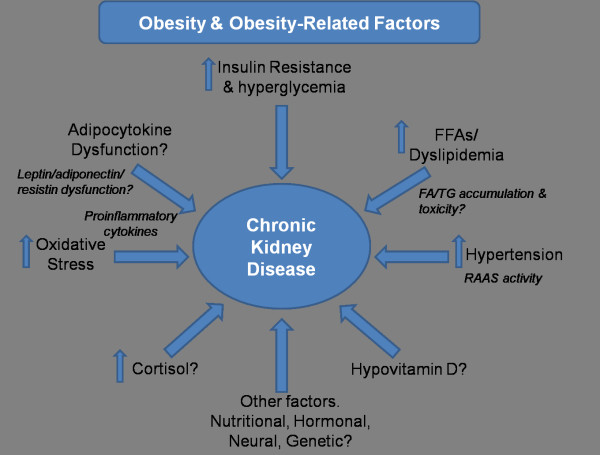
A range of ‘obesity and obesity-related’ factors have been suggested to be implicated in the progression of chronic kidney disease, CKD. These include; general insulin resistance and progressive hyperglycemia. Heightened free fatty acids, FFAs common in obesity may lead to further insulin resistance and FA/TG fatty acid/triglyceride accumulation locally within tissues –which may be implicated in cellular dysfunction (e.g. the promotion of cell death pathways). Hypertension is common in obesity and metabolic syndrome and may be due to a range of factors including heightened sympathetic nervous system activation and angiotensinogen release from adipose tissue. The hypertension may have a direct damaging effect on microvasculature within renal tissues and via the actions of heightened renin angiotensin aldosterone system, RAAS activity. The dysregulation of adipose tissue-derived adipocytokines such as leptin and adiponectin and proinflammatory cytokine release may strengthen obesity-related factors including insulin resistance, dyslipidemia and oxidative stress. Other factors potentially implicated may include resistin, corticosteroids (potentially via increased adipose tissue production and hypothalamic pituitary stimulation), hypovitamin D status and other nutritional and genetic factors (e.g. gene polymorphisms). Note that the precise mechanisms in human in vivo CKD are yet to be fully elucidated, and is speculation at present, based upon association studies, cell and animal studies and pharmacological manipulation.